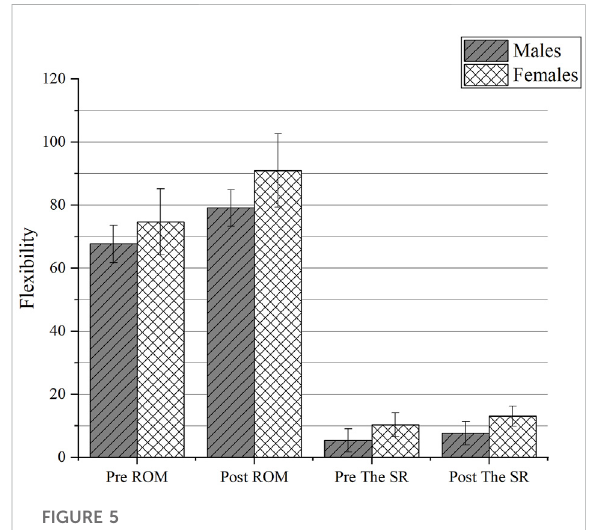
FIGURE 6 The change of muscle stiffness of triceps calf muscles between genders. Abbreviations: MG, medial gastrocnemius muscles;LG,lateralgastrocnemiusmuscles;SOL,soleus;Pre,pre- stretching; Post, post-stretching.